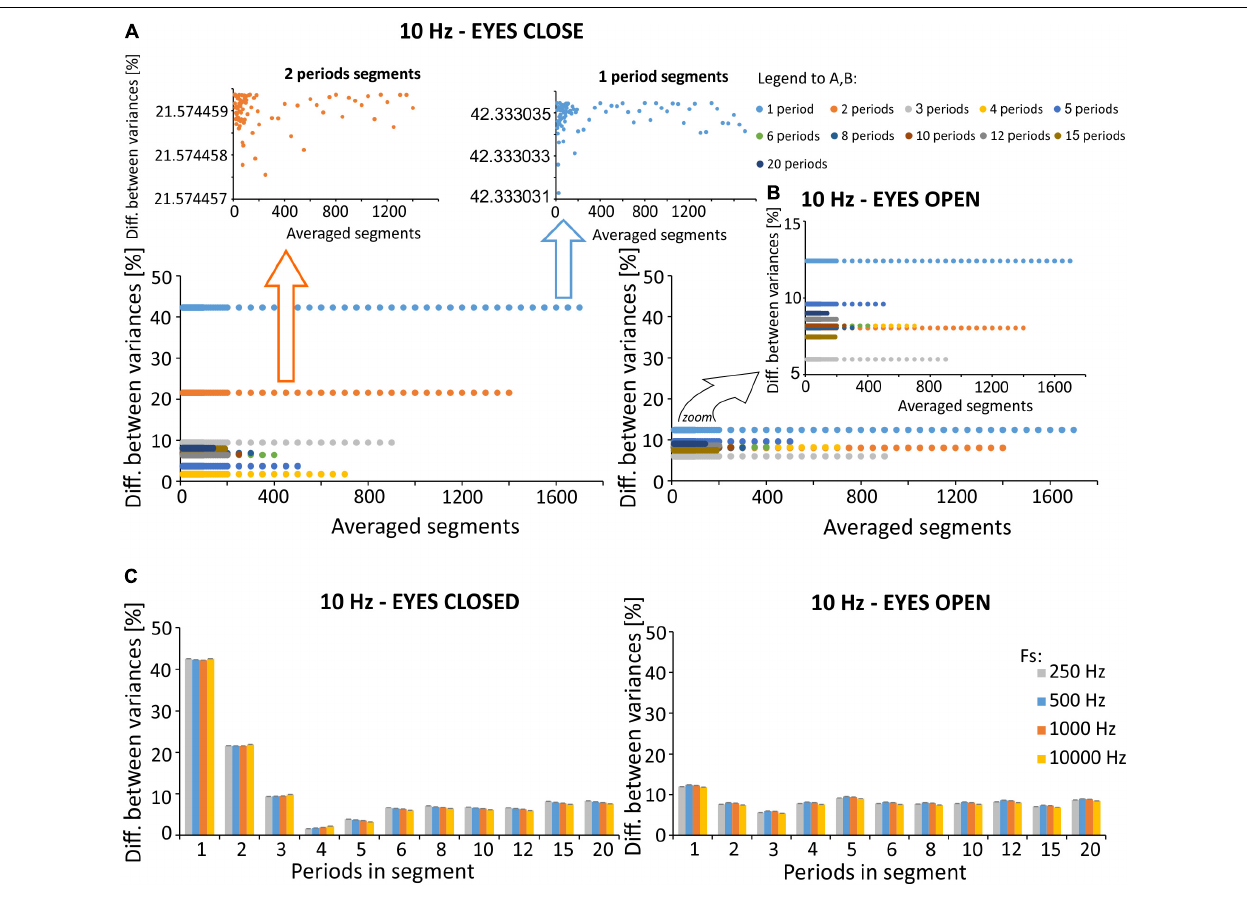
FIGURE 8 | Percent difference between signal variances for the various exemplar selected simulation, calculated according to the relationship described in Formula (8). (A) Difference in variance for a varying number of periods per segment, prepared using signal with excitation in the alpha band (eyes closed). Zoomed-in displays for 1- and 2-period segments were prepared to improve visibility of relatively small differences that vary based on averaged segments for the selected number of periods per segment. (B) Difference in variance for various number of periods per segment prepared using signal with inactivity in the alpha band (eyes open). (C) Averaged differences for various number of periods determined for different sampling frequencies. The original signal was recorded with a sampling frequency of 10 000 Hz, and downsampled in factors of 10, 20, and 40. This allowed us to analyze the signal with a sampling frequency of 1000 Hz, 500 Hz, and 250